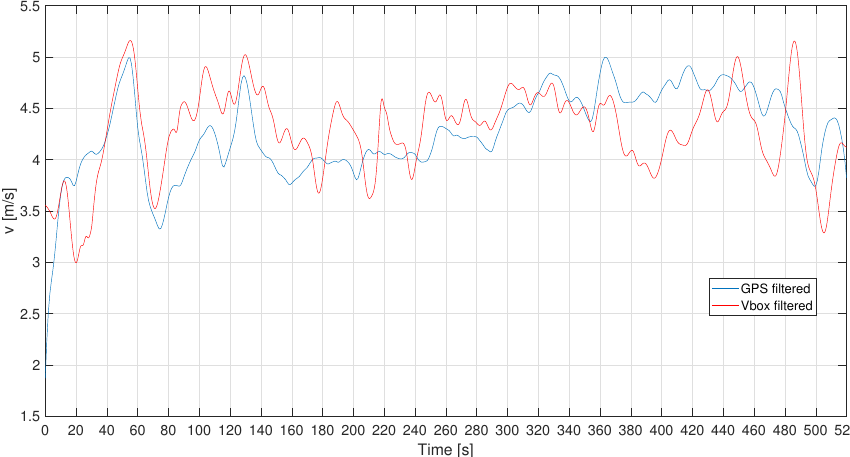
Figure 16. L1—VBOX and GPS velocity filtered